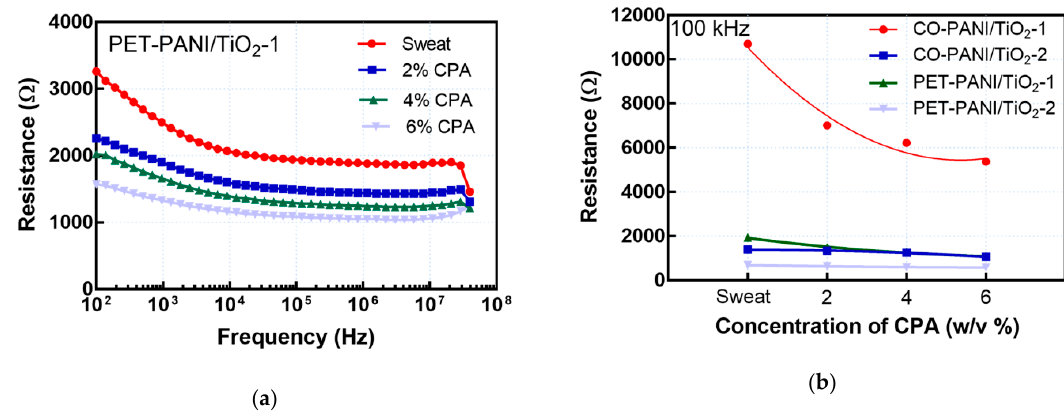
Figure 5. ( a ) Resistance as a function of frequency for PET-PANI/TiO 2 -1 and for different fluids soaking the fabric; ( b ) Resistance as a function of cyclophosphamide (CPA) concentration for different fabrics.